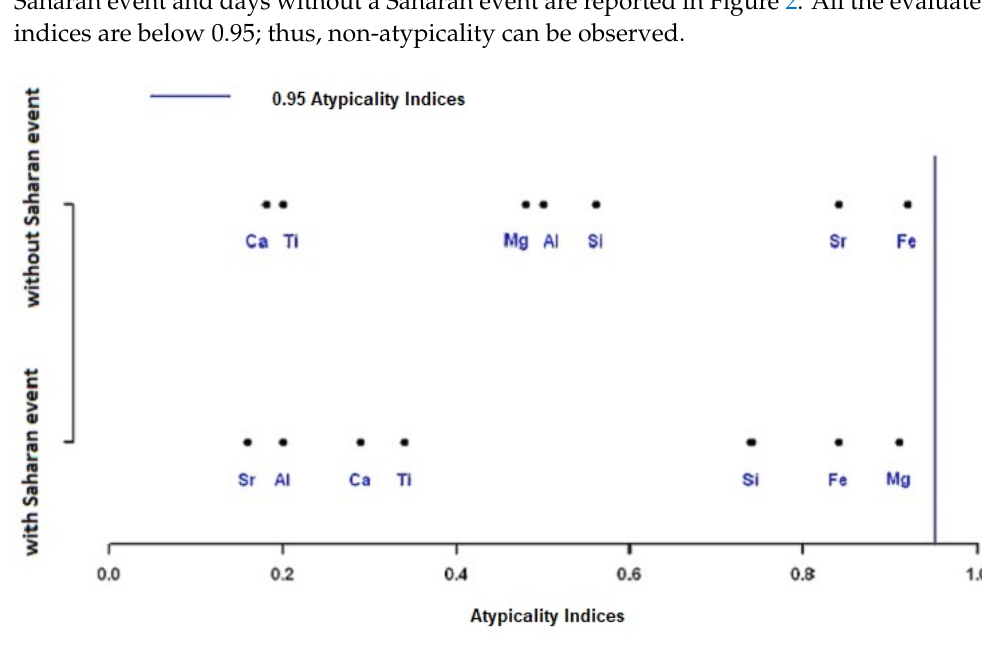
Figure 2. Atypicality indices for data relating to days with and without a Saharan event.